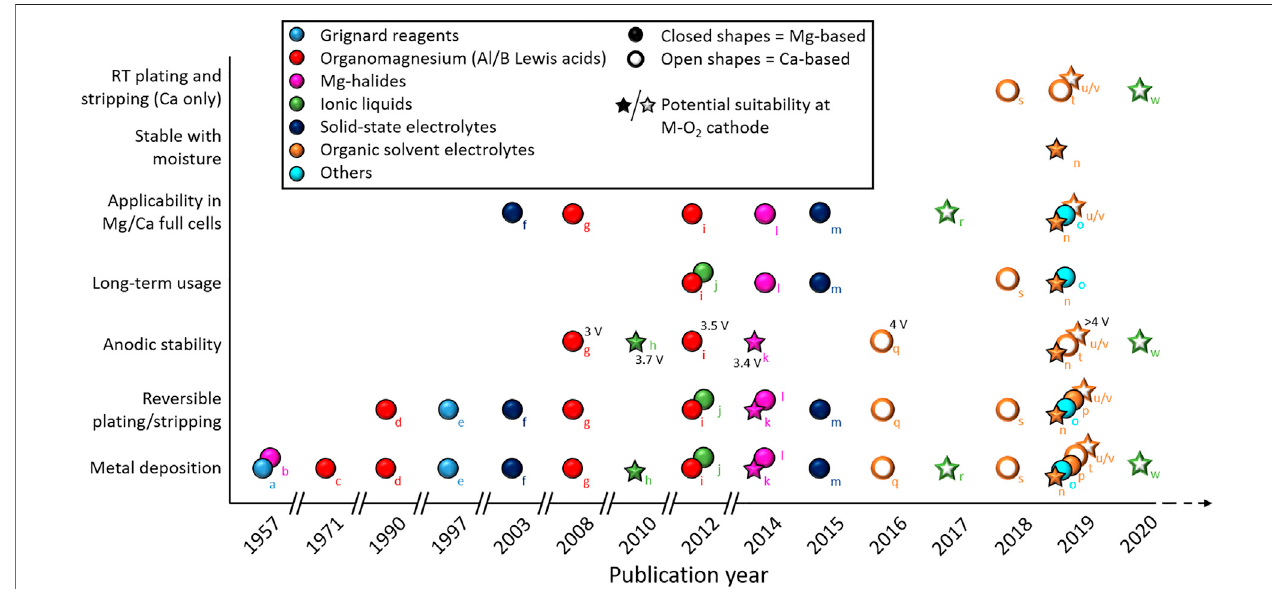
FIGURE3| Summary fi gureoftheprogressofelectrolyte development,highlighting varioustechnicalachievements,forMg(closedshapes) and Ca(openshapes) plating/stripping cycling. Electrolytes are grouped by color to show the type of materials used and the star symbols highlight particular formulations that possess propertiesmakingthempromisingcandidatesforfutureinvestigationsinMg/Ca-O 2 batteries.Labelsa-wrefertoliteraturecitedinthissectionandaresummarizedinthe supporting information (RT (cid:2) room